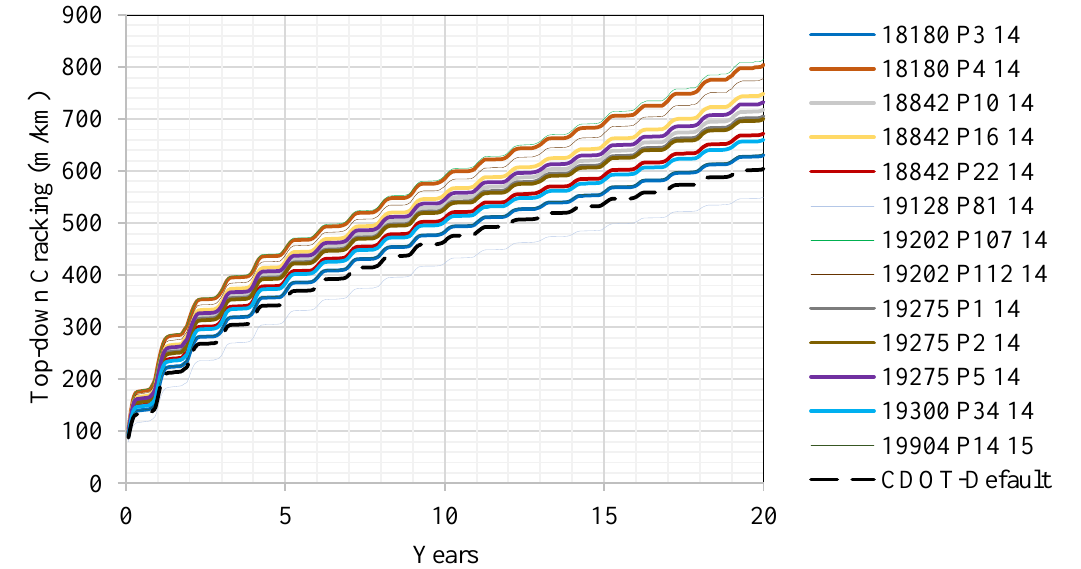
Figure 6. Longitudinal cracking due to AADTT = 7000 by SX (100) PG 64-22 mix. To determine the influence of V be , V a , VMA, VFA, and AC, a regression analysis is conducted, and the following correlations are obtained. The R 2 of the correlations of IRI, total rutting, rutting in HMA, FC, and TDC are 0.65, 0.60, 0.59, 0.65, and 0.64, respectively. It can be seen that all distresses increase with the increase in VMA, VFA, and AC, and decrease with the increase in V be and V a . This regression analysis is for the mix, SX (100) PG 64-22. IRI (mm/km) = 1579.92 − 34.369 V be − 14.363 V a + 66.184 VMA + 17.604 VFA + 22.423 AC Total rutting (mm) = −12.11 − 0.5258 V be − 0.165 V a + 0.9525 VMA + 0.2515 VFA + 0.3048 AC Rutting in HMA (mm) = −14.2977 − 0.4775 V be − 0.198 V a + 0.922 VMA + 0.2388 VFA + 0.2134 AC FC (%) = −13.1366 − 0.461 V be − 0.1364 V a + 0.9536 VMA + 0.2036 VFA + 0.5026 AC TDC (m/km) = −467.33 − 19.12 V be − 7.7193 V a + 33.1948 VMA + 9.818 VFA + 11.2242 AC The AASHTOWare outputs for the other mixes listed in Table 1 are analyzed using the same procedure as discussed for the SX (100) PG 64-22 mix here. The influences of different mix factors are not consistent, as observed in the group analysis. The summary of the influence of different mix factors is provided in Table 6. Different mixes produce different regression coefficients. The reasons may be different aggregate sources, different technicians, human errors, binder source, etc. All distresses except rutting in HMA increase with an increase in V a , VMA, and VFA, and are insensitive to V be and AC in the study range of these parameters. Rutting in HMA increases with an increase in VMA and VFA, and is insensitive to V be , V a , and AC.